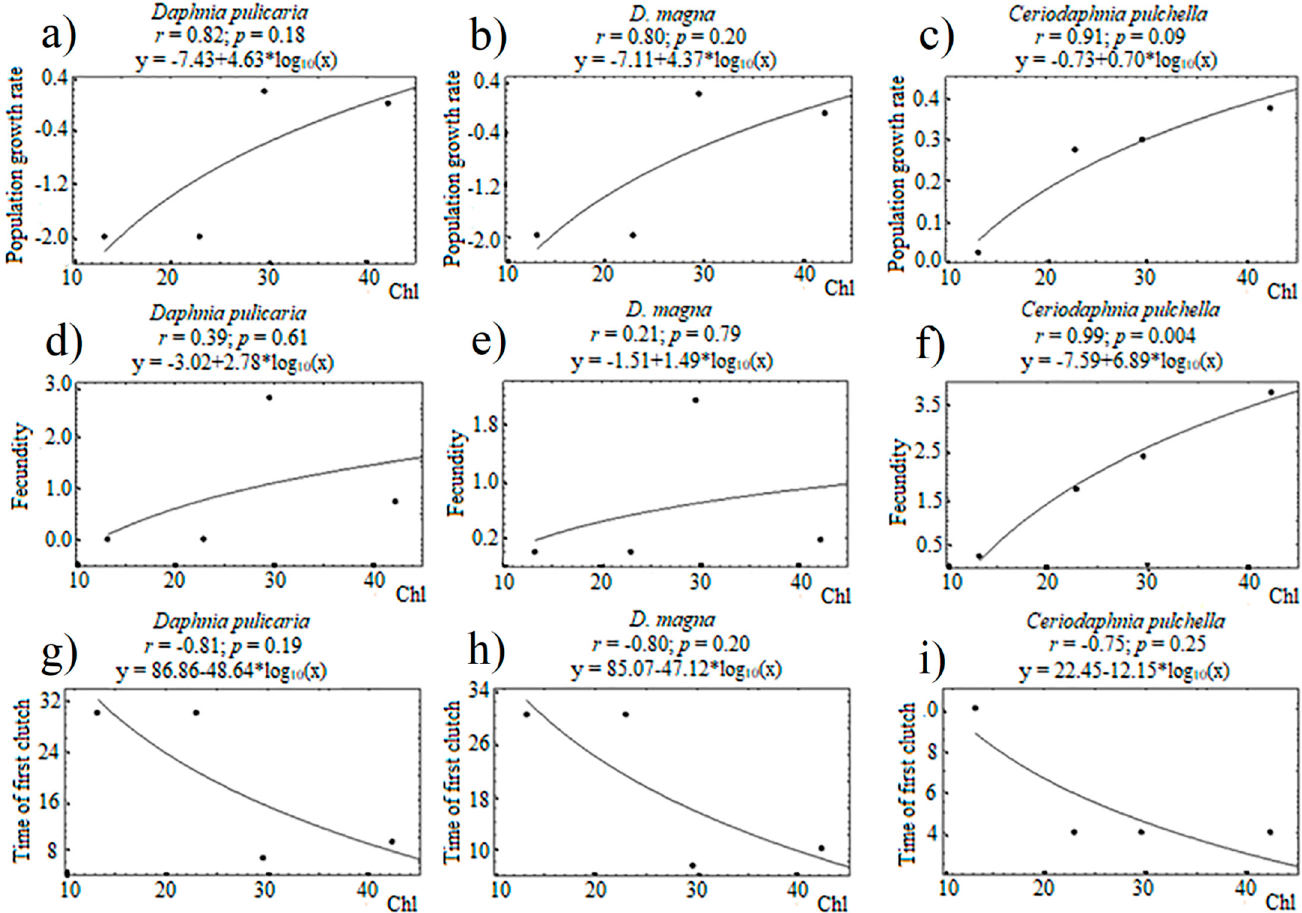
Figure 9. Relationships between total chlorophyll (Chl) and population growth rate of D. pulicaria ( a ), D. magna ( b ), and C. pulchella ( c ); between total chlorophyll and fecundity of D. pulicaria ( d ), D. magna ( e ), and C. pulchella ( f ); between total chlorophyll and time of first clutch of D. pulicaria ( g ), D. magna ( h ), and C. pulchella ( i ) in the mesocosms. Above the graphs is the correlation coefficient, the significance level of the regression equation and the regression equation.